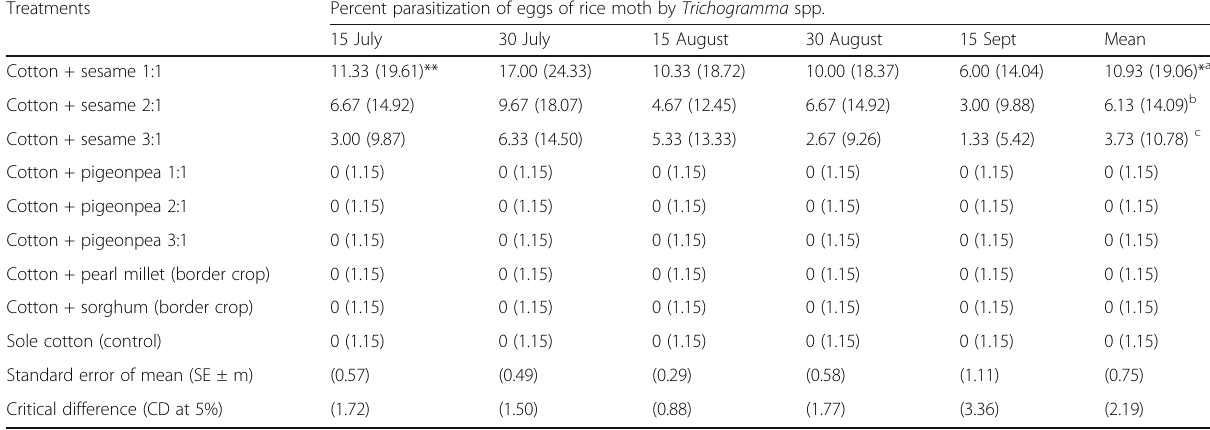
Table 2 Effect of intercropping on the activity of Trichogramma spp. (pooled of 2016 and 2017) Treatments Percent parasitization of eggs of rice moth by Trichogramma